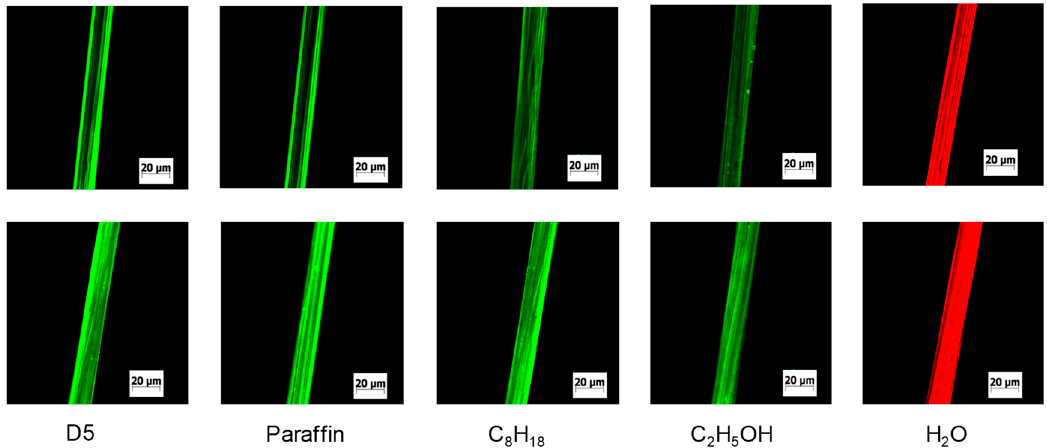
Figure 3. Confocal fluorescence images of viscose in different media: The fibers which were treated at 25 °C for 1 min as the control samples (top row); and the fibers which were treated at 60 °C for 20 min as the swelled samples (bottom row).